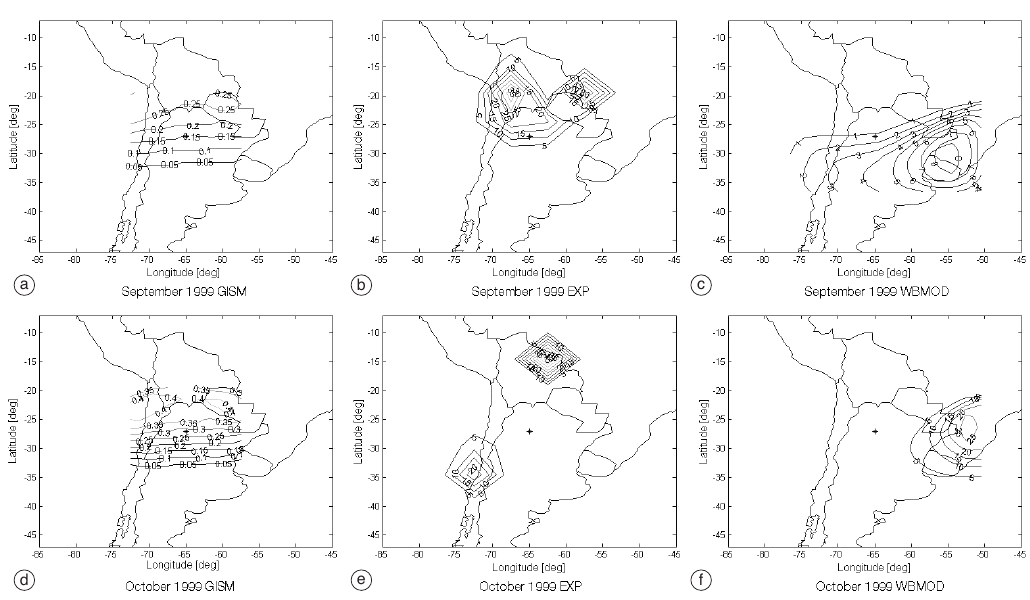
Fig. 6a-f. Percentages of occurrence of S 4 > 0.5 for experimental data and WBMOD and predicted S 4 values by GISM are shown at 20 LT during the day 15 of each month (September and October